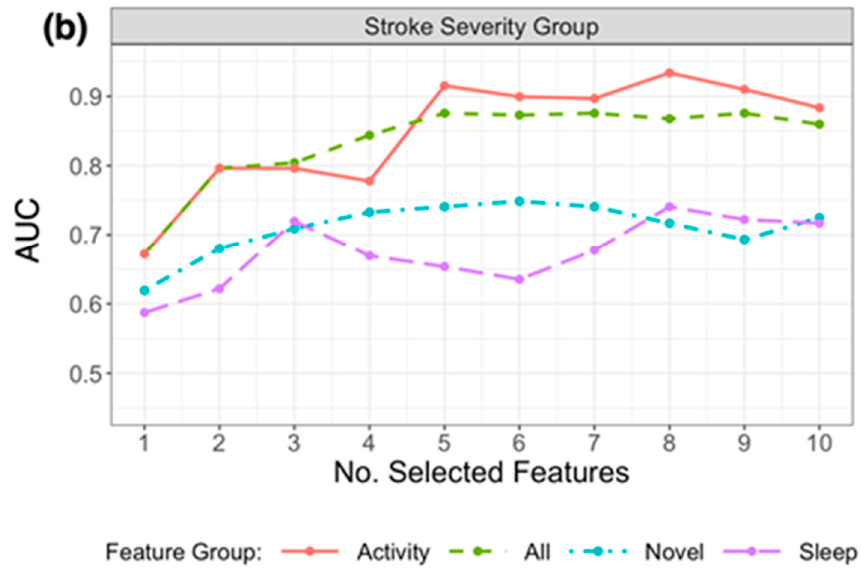
Figure 3. Plot of AUC results for replicating ( a ) diagnosis labels and ( b ) stroke severity group using